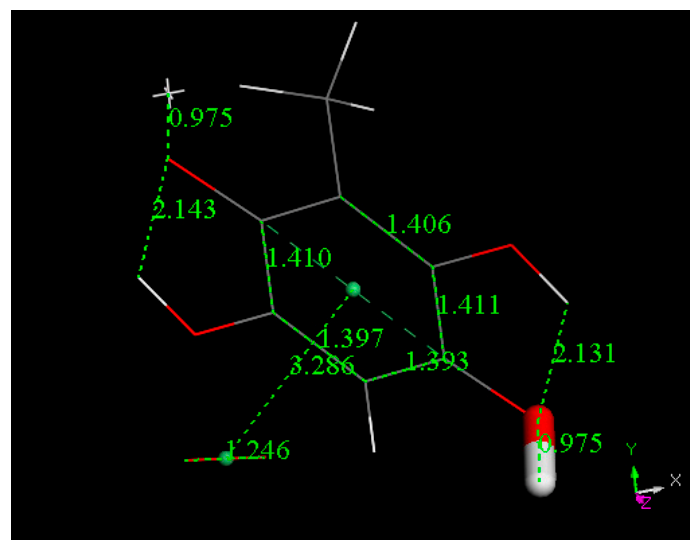
Figure 9. An additional H 3 O + is reacted at the remaining O(carbonyl) of [embelin-model-H] - , and the proton is also captured. Δ G = − 38.3 kcal/mol.